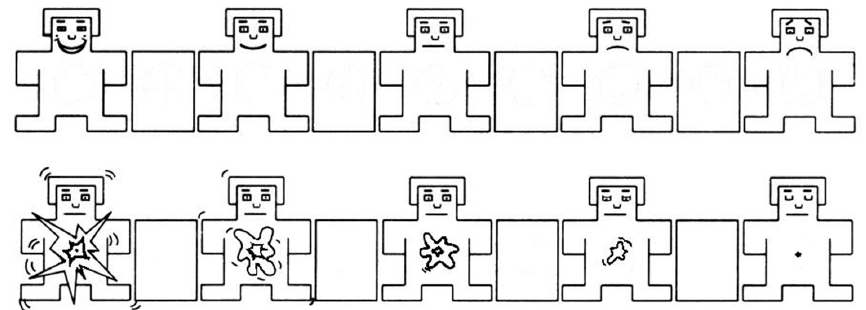
Figure 2. Self-assessment for arousal and valence.